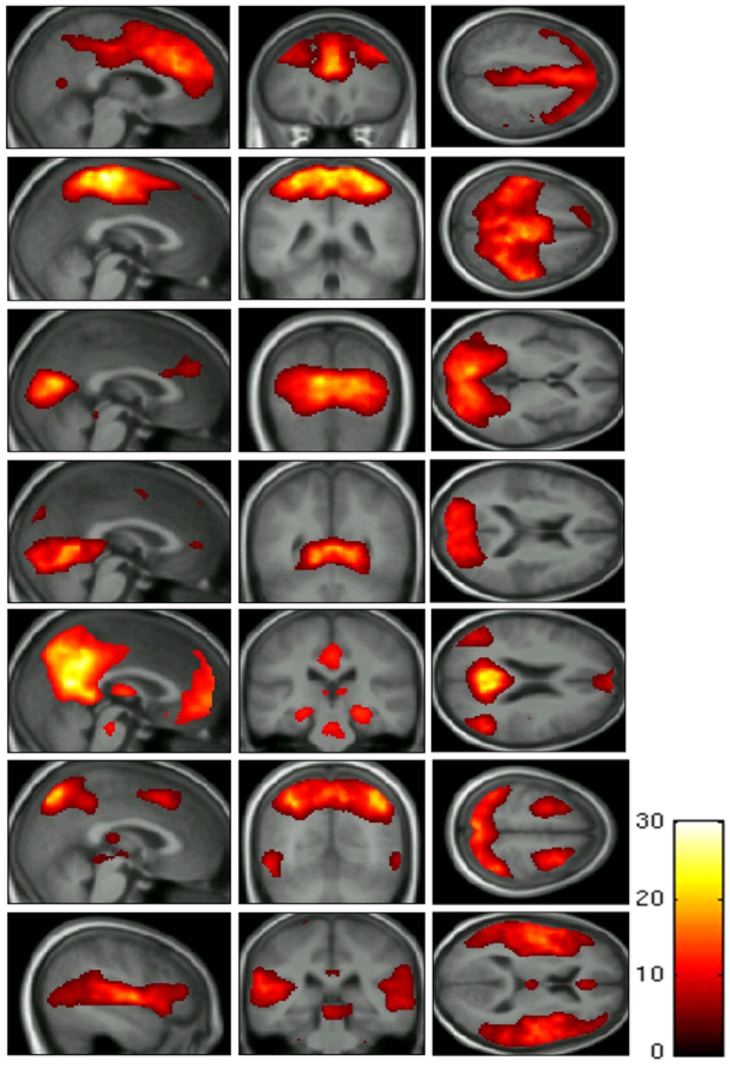
Group analyses of the independent component analysis revealing seven distinct resting state networks (default mode, dorsal attention, auditory, frontal, sensorimotor lateral and medial visual network).